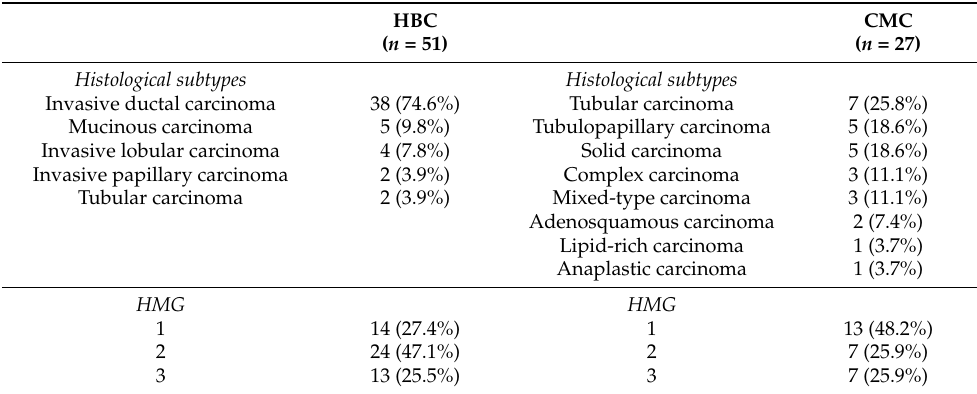
Table 2. Histological subtypes and malignancy grade (HMG) of human breast cancer (HBC) and canine mammary cancer (CMC) samples prospectively included in the